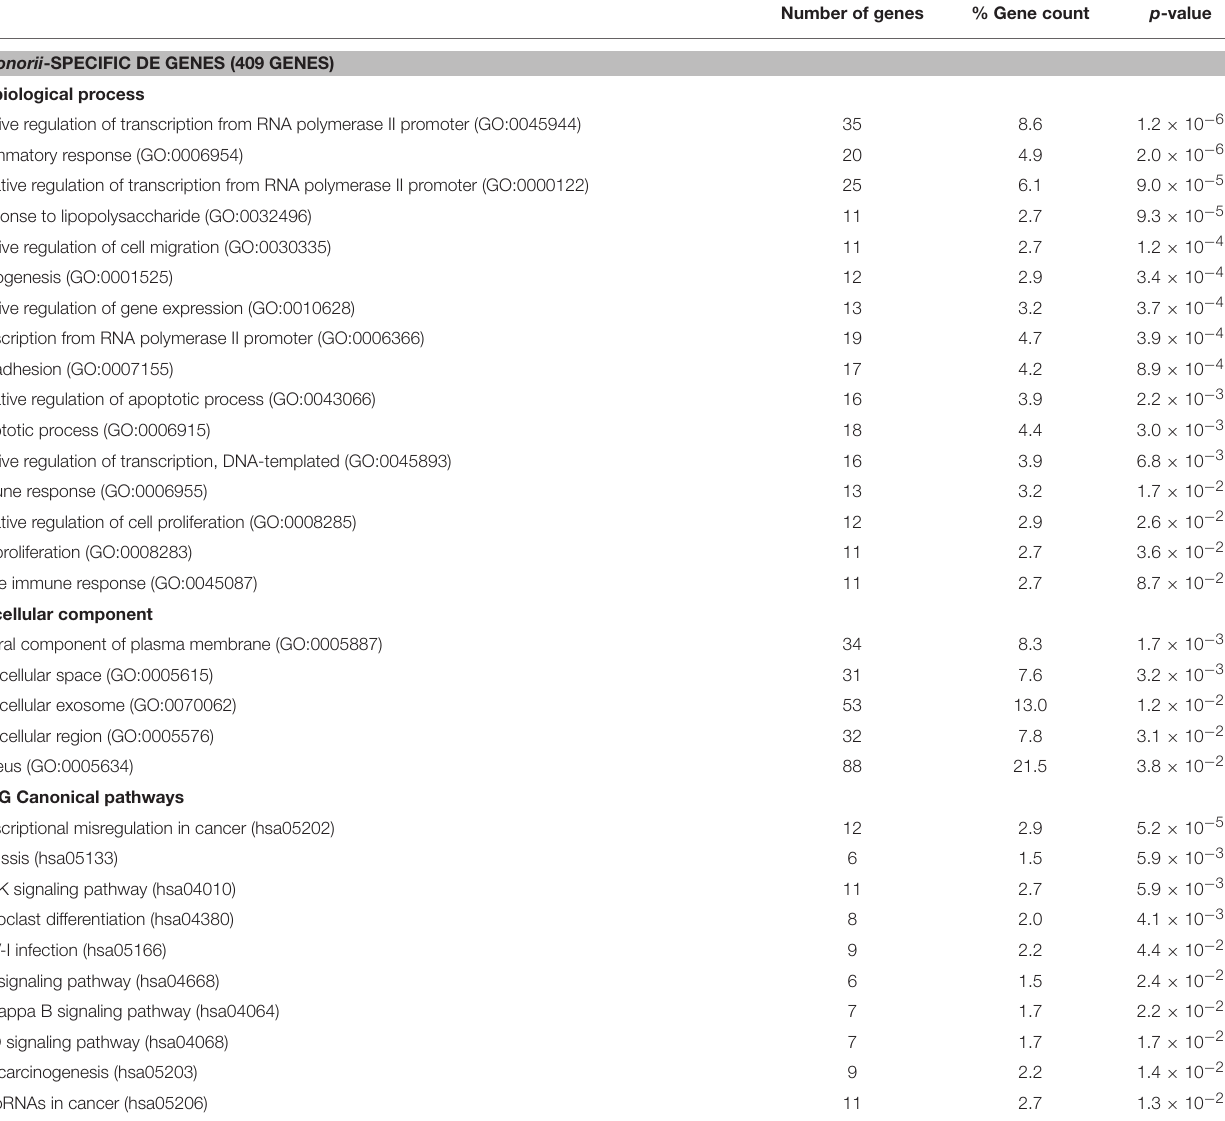
R.conorii-specificDEgenesarecategorizedusingDAVIDBioinformaticResources6.8accordingtoGOterms:biologicalprocessandcellularcomponent,andKEGGcanonicalpathways.